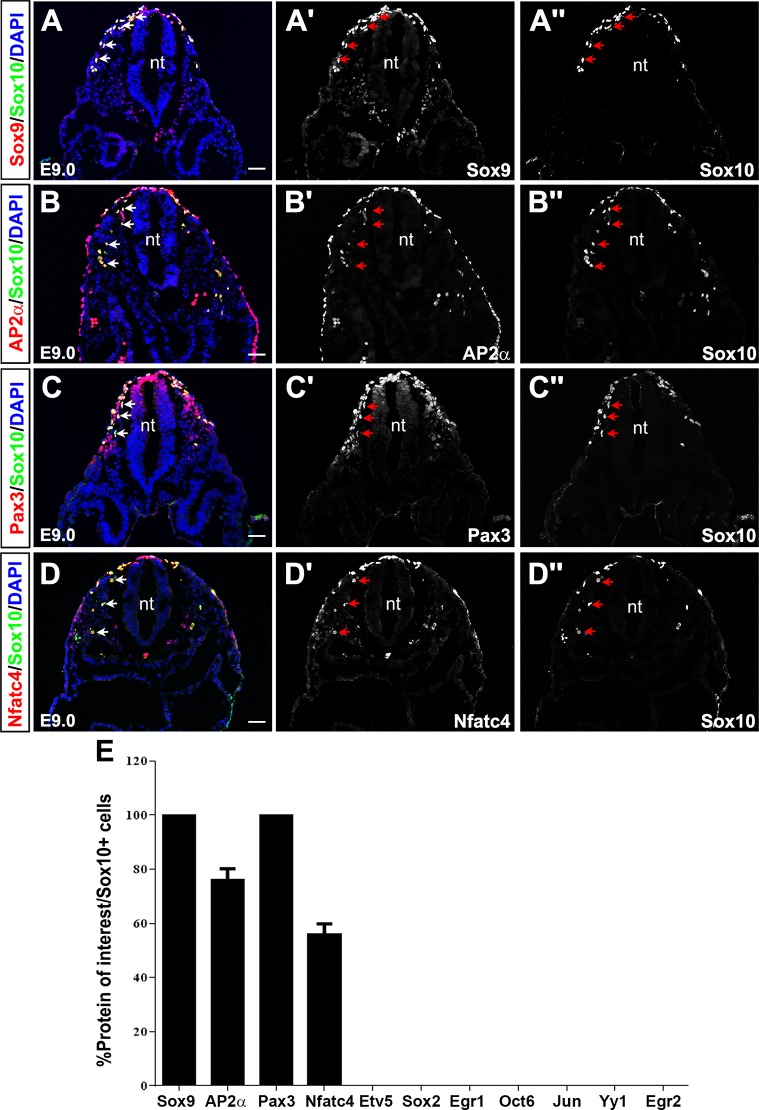
Expression of SC lineage markers in E9.0 NCCs.(A-E,A'-D',A''-D'') Co-expression of Sox10 with Sox9 (A-A''), AP2α (B-B''), Pax3 (C-C''), Nfatc4 (D-D'') in E9.0 NCCs. A-D are merged images of Sox10 (green) and protein of interest (red). Blue is DAPI counterstain. A'-D' shows expression profiles of the protein of interest, while A''-D'' show Sox10 expression. Arrows indicate co-expression of protein of interest with Sox10 in NCCs taking the ventral migratory pathway. Quantification of percent Sox10+ co-expression with each of the proteins of interest (E). Error bars = S.E.M. nt, neural tube. Scale bars, 40μm.